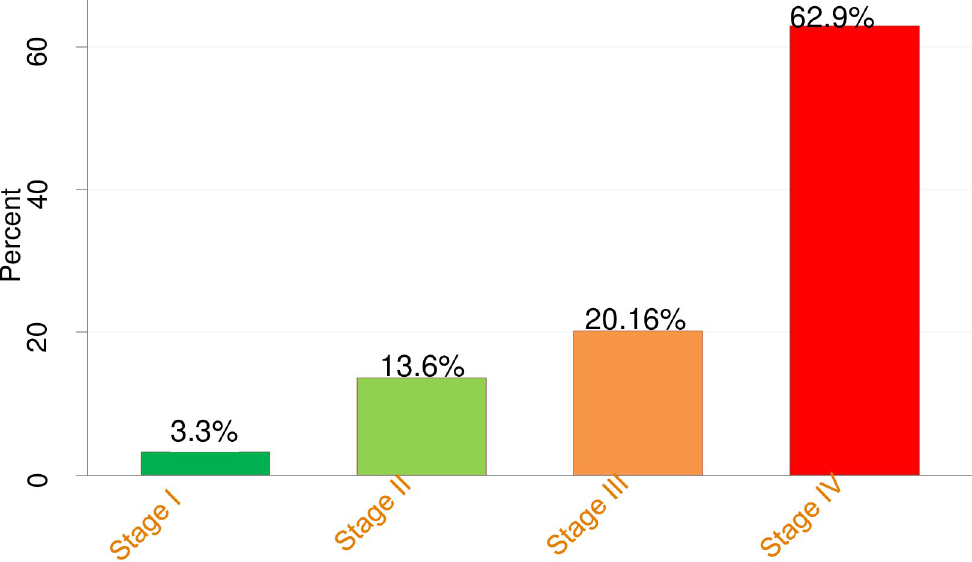
Fig 1. Distribution of the disease stage on presentation of colorectal cancer